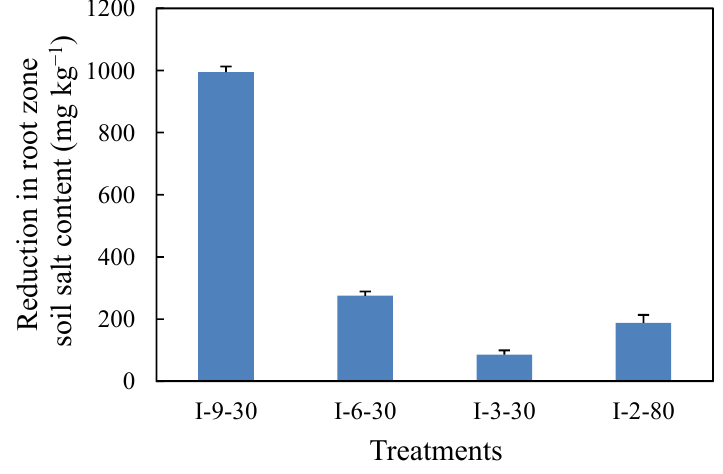
Figure 3. Mass reduction in 20-cm root zone salt content in the saline-sodic soil before rice transplanting and after rice harvesting (mg kg − 1 ). The error bars represent the standard deviation.